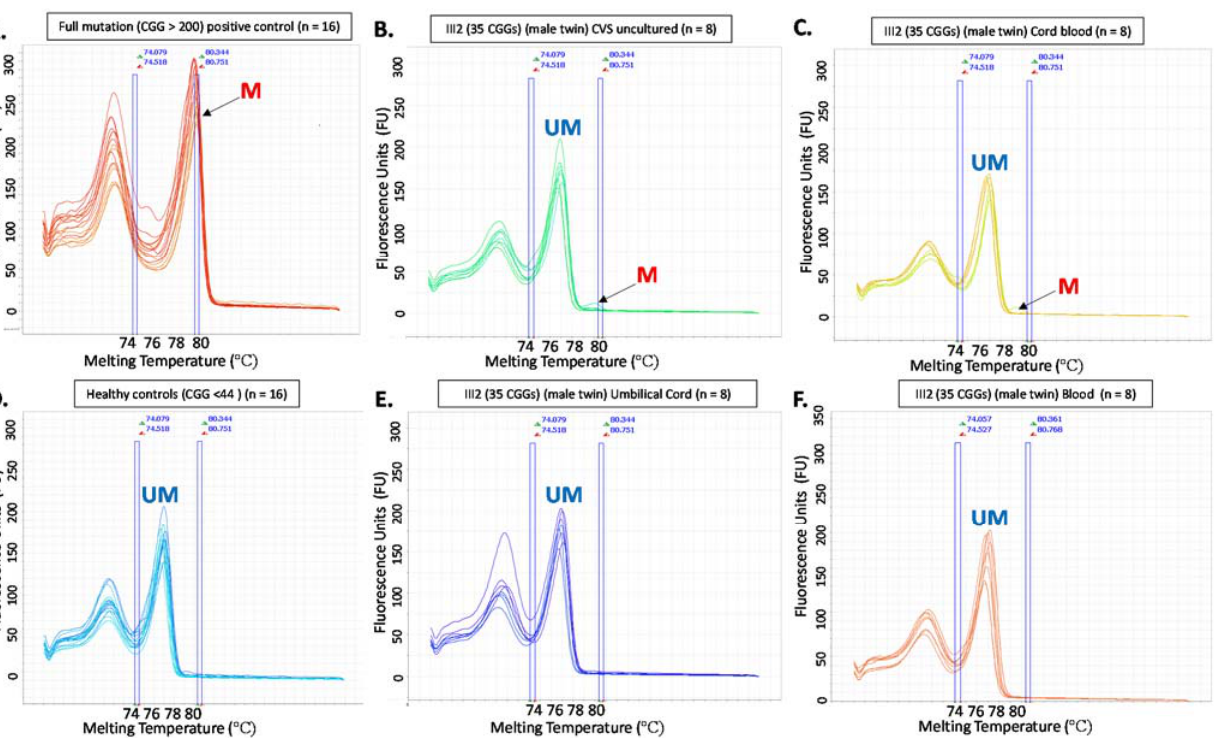
Figure 3. High resolution melt derivative plots from Methylation Sensitive Quantitative Melt Analysis (MS-QMA) analysis of Fragile X-Related Epigenetic Element 2 (FREE2) methylation in the male twin (III-2). Derivative plots in pre and postnatal tissues ( A – F ) represent cluster results based on similarities of melt curve placement and shape as determined using the Applied Biosystems ® High resolution Melt Software (Thermo Fisher Scientific, Global). Positive and negative controls ( A ) and ( D ) have been included for comparison with the results for the male twin’s samples ( B , C , E and F ), providing details about the presence or absence of the abnormally methylated (M) and unmethylated (UM) FMR1 alleles. The numbers above each panel represent technical replicates. Note: for each plot X-axis represents melting temperature, while y-axis represents fluorescence released, with each fluorescence unit (FU) equal to 1000 units generated by the Applied Biosystems ® High resolution Melt Software (Thermo Fisher Scientific, Global).